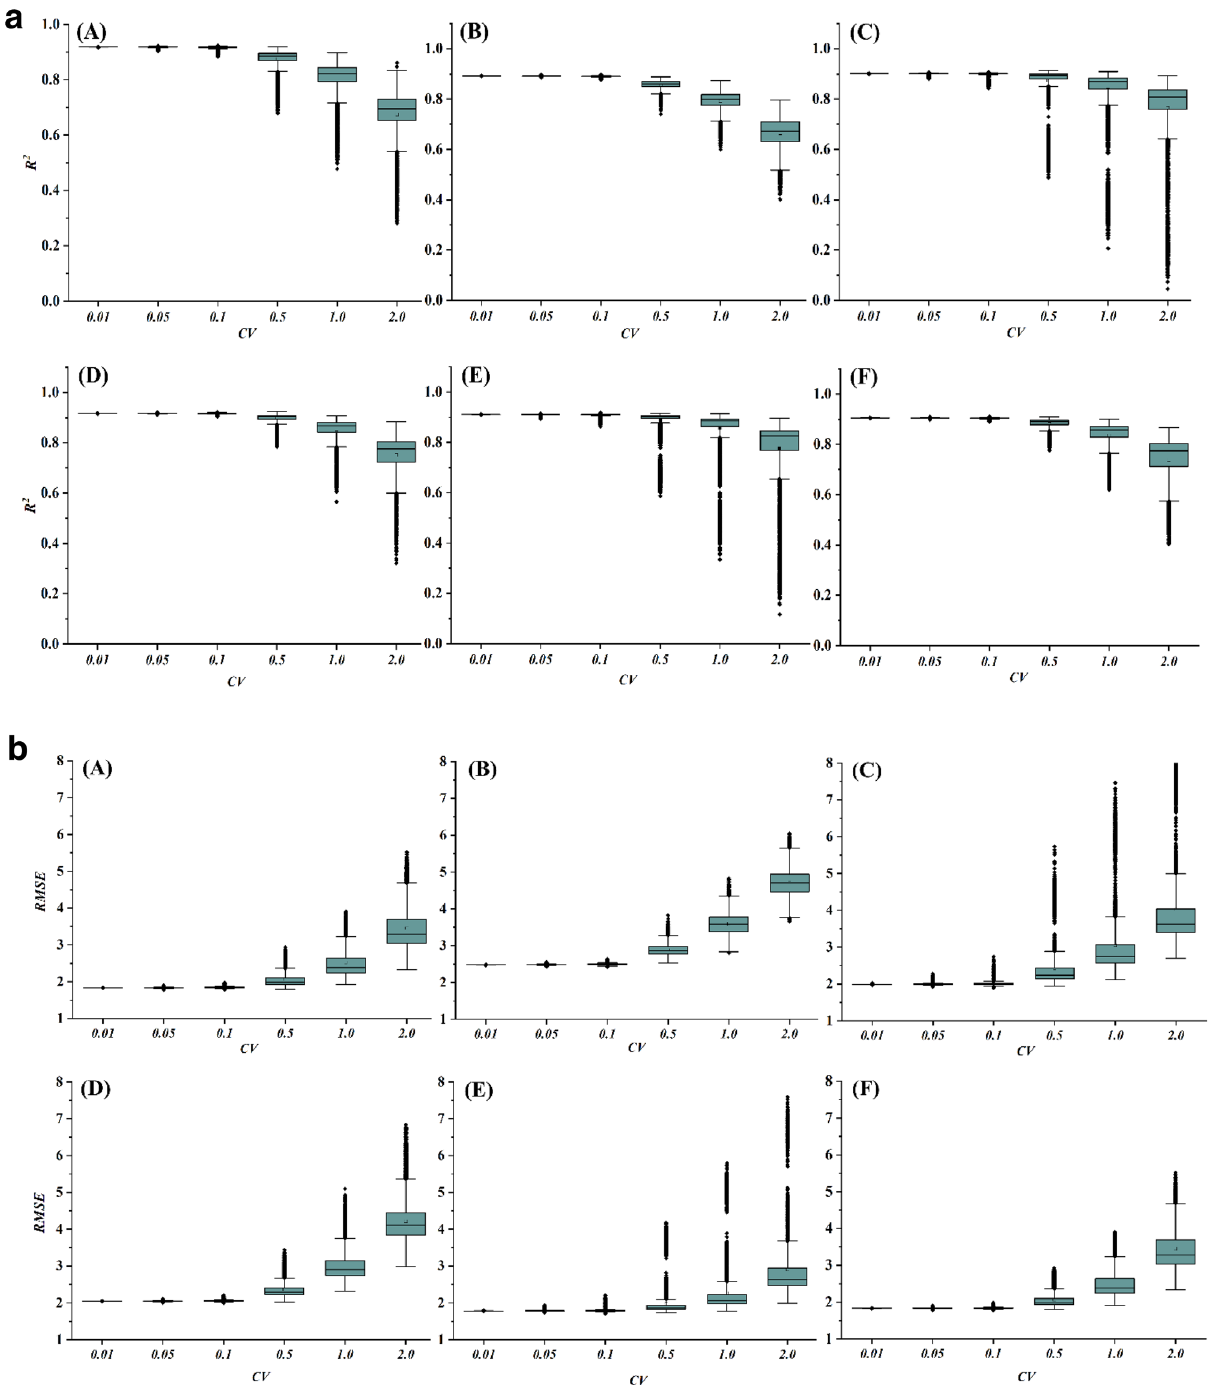
Figure 6. ( a ) Variation of R 2 when a station has random data with different CV : A = Sylhet, B = Srimangal, C = Rangpur, D = Mymensingh, E = Dinajpur and F = Bogra. ( b ) Variation of RMSE values when a station has random data with different CV : A = Sylhet, B = Srimangal, C = Rangpur, D = Mymensingh, E = Dinajpur and F =